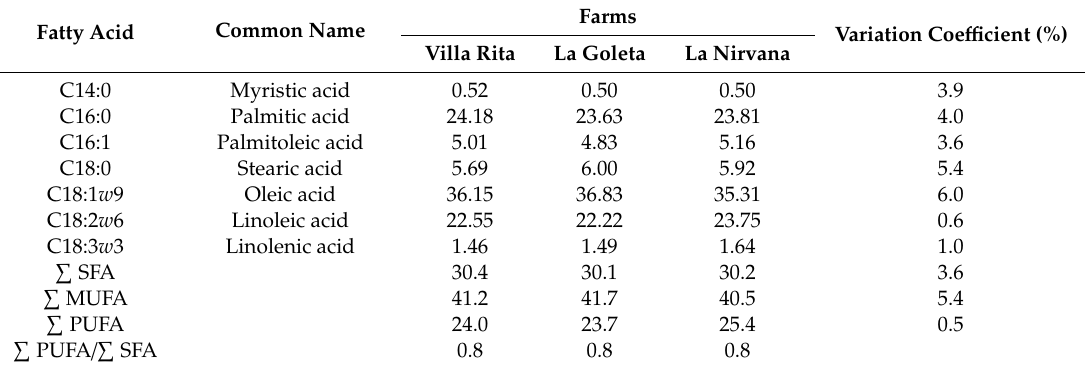
Table 3. Lipid profile (% of total lipids) of chicken fat by-products from the three farms under study.